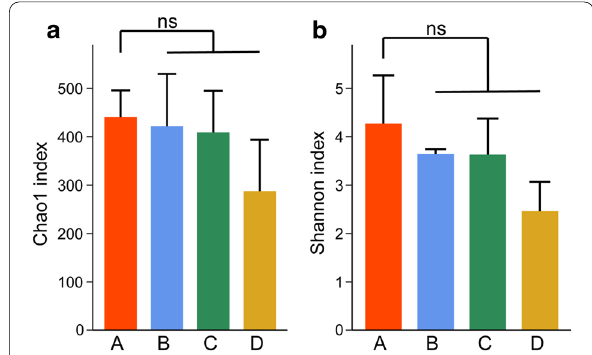
Fig. 3 Alpha diversity metrics of fecal bacterial communities. a Histogram for comparison of species richness (Chao1 index) between the four groups. b Histogram for comparison of species diversity (Shannon index). (ns: not significant)